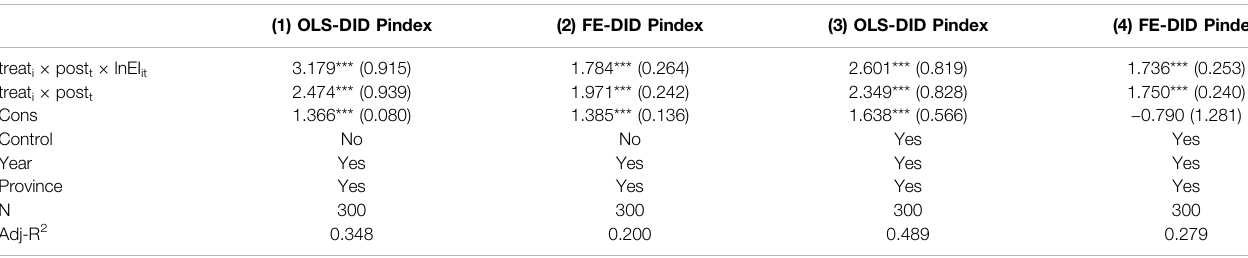
TABLE 5 | Regression results of environmental regulation